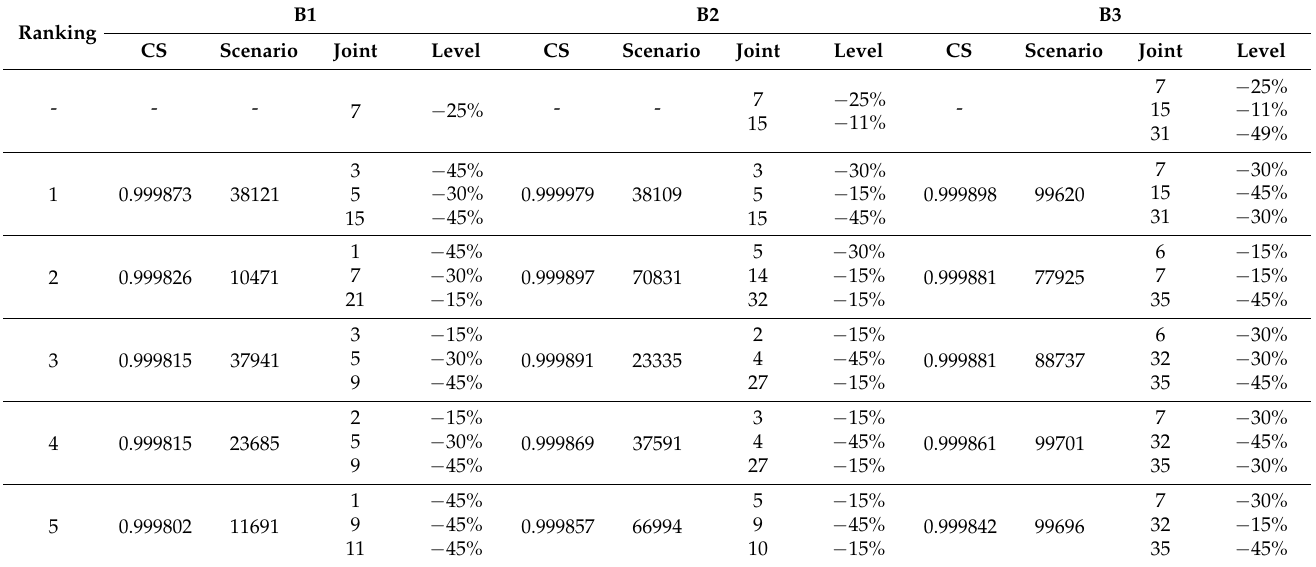
Table 8. Damage scenarios ranked in the top five and the corresponding cosine similarities (CS) of test case